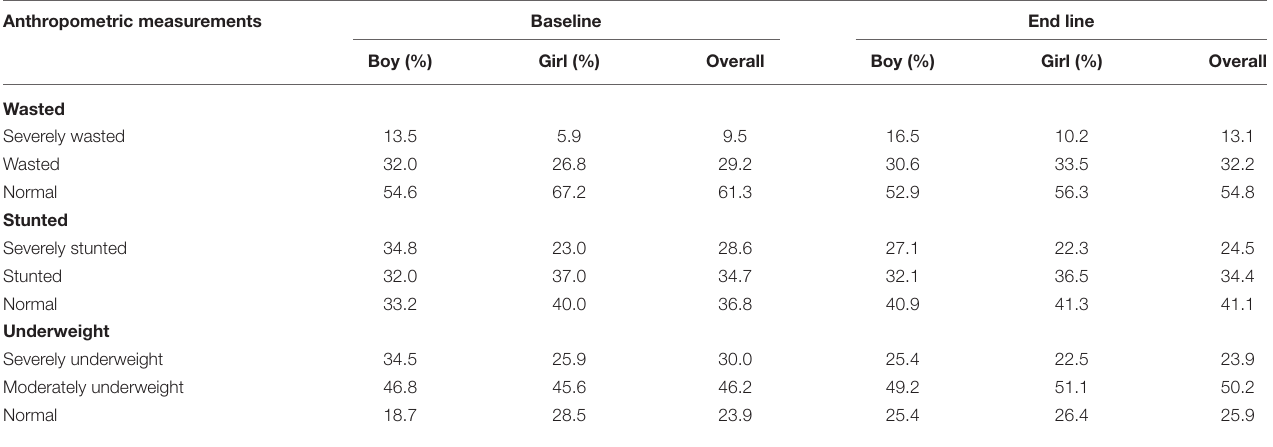
TABLE 6 | Nutritional status of the